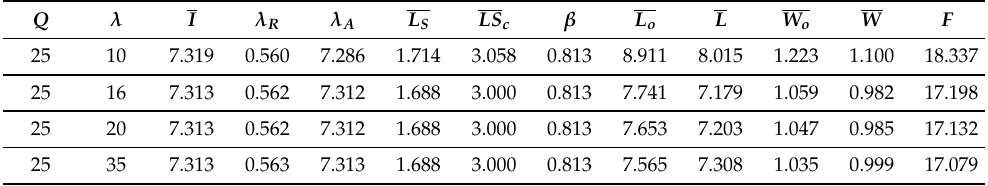
Table 7. The effect of µ on performance measures at Q = 25.